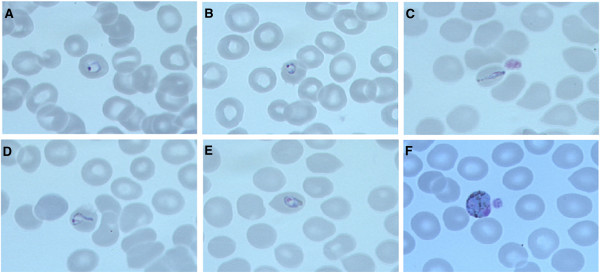
Giemsa-stained thin blood smears with Plasmodium knowlesi parasites (magnification: 100×, oil immersion). Panels A and B display ring stage parasites. Panel C shows a band-form. Panels D and E show late trophozoite parasites. Panel F displays a gametocyte.